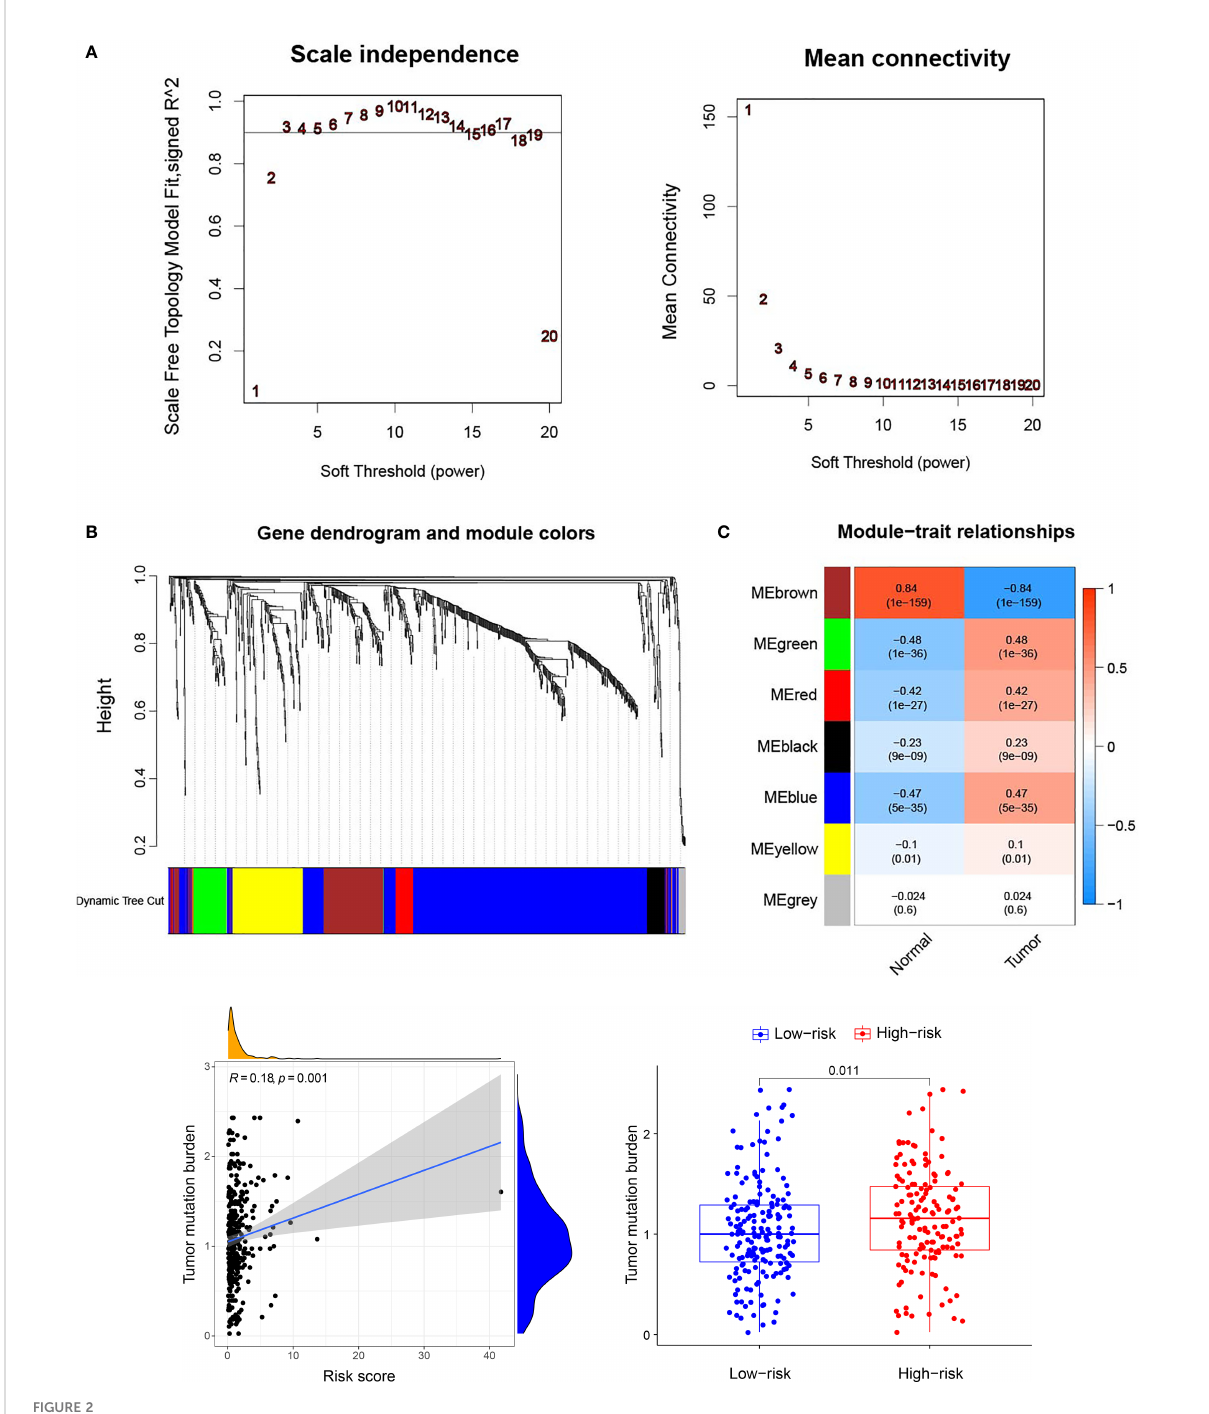
FIGURE 2 (A) Determination of the soft-thresholding power in the WGCNA analysis. The correlation coef fi cient was greater than 0.9, and the optimal soft- thresholding power was 3. (B) WGCNA of immune-related differentially expressed genes with a soft threshold b = 3. (C) Gene modules related to ccRCC obtained by